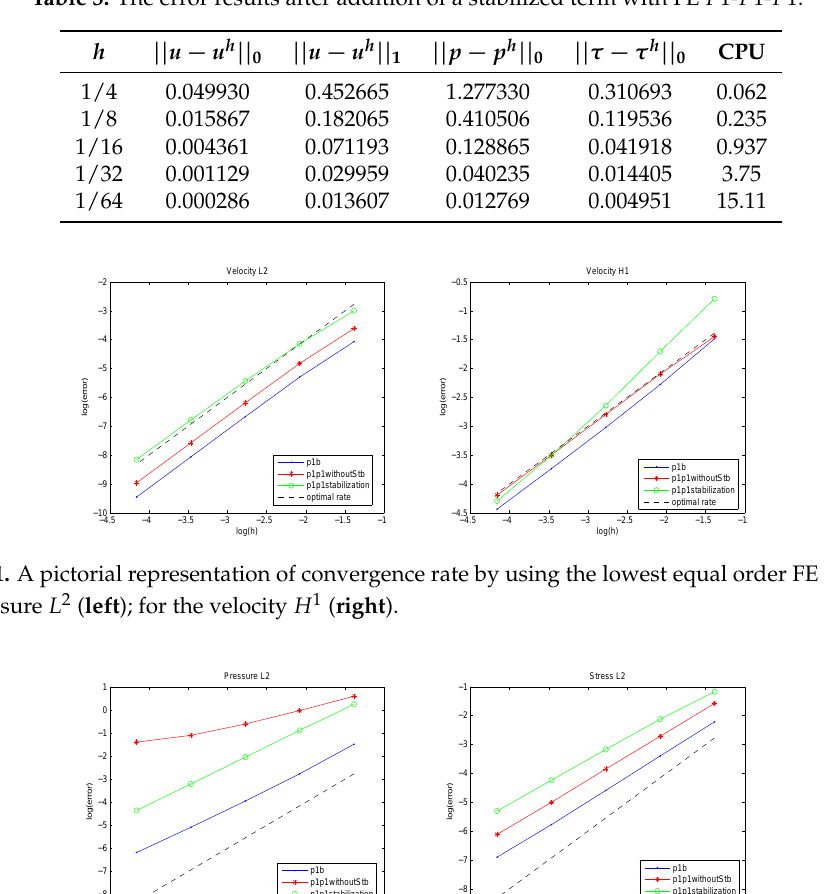
Table 3. The error results after addition of a stabilized term with FE P 1- P 1- P 1.